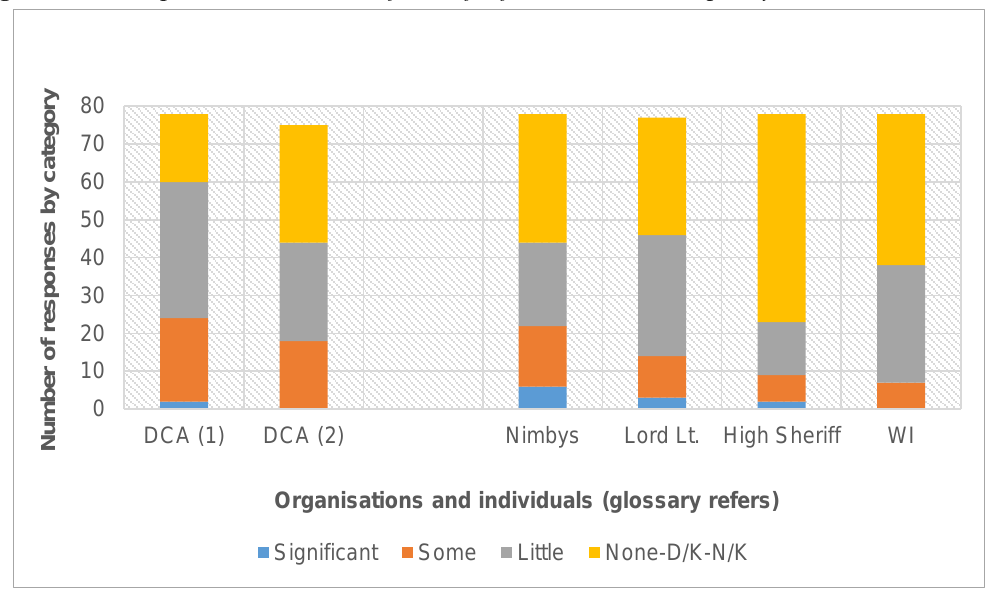
The ‘county’ categories, NIMBYs, the WI, the Lieutenancy and the Shrievalty (Figure 8) are also thought to have little influence. Figure 8: Participants’ assessments of loci of influence over rural policy in West Dorset